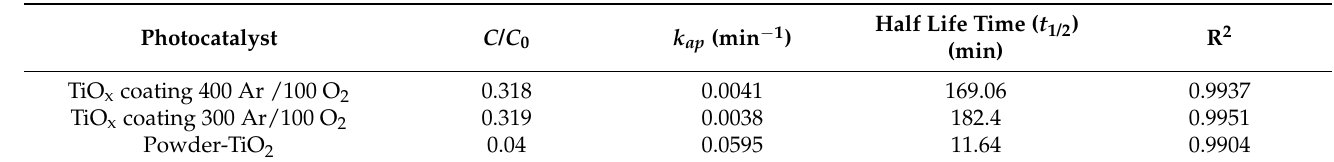
Table 5. Kinetic data of the photo-catalytic degradation of rhodamine B over Ag-TiO x catalyst deposited by arc-PVD.